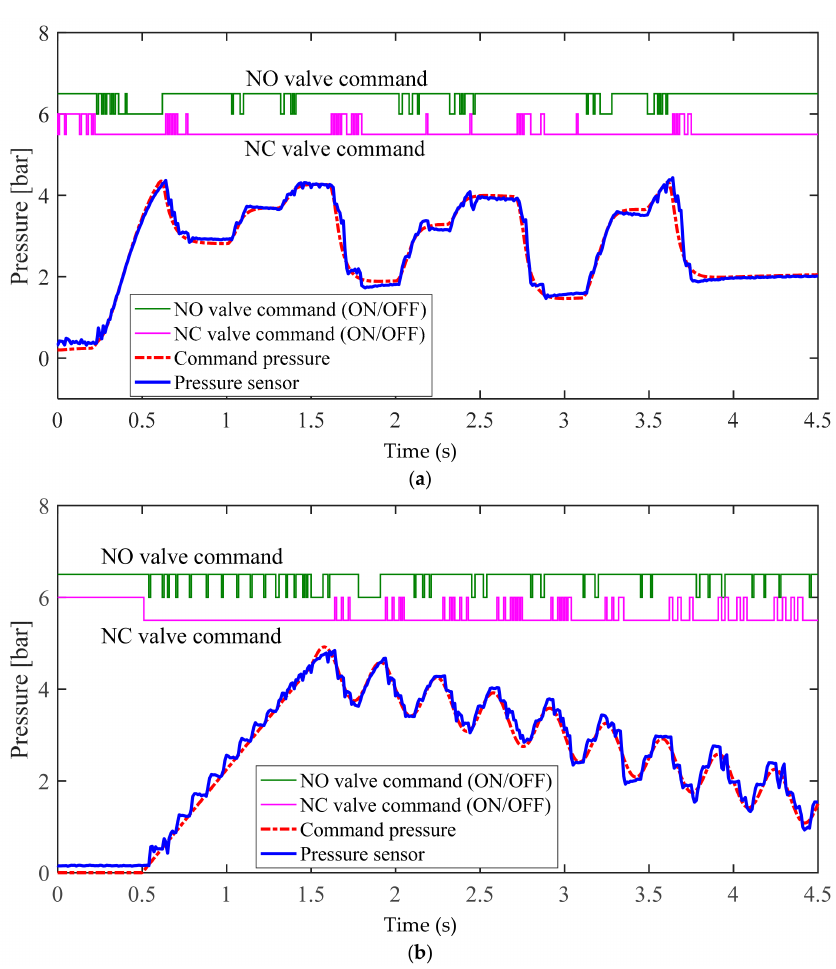
Figure 11. Experimental results for proposed pressure control method in the ( a ) normal braking case and the ( b ) ABS control case.